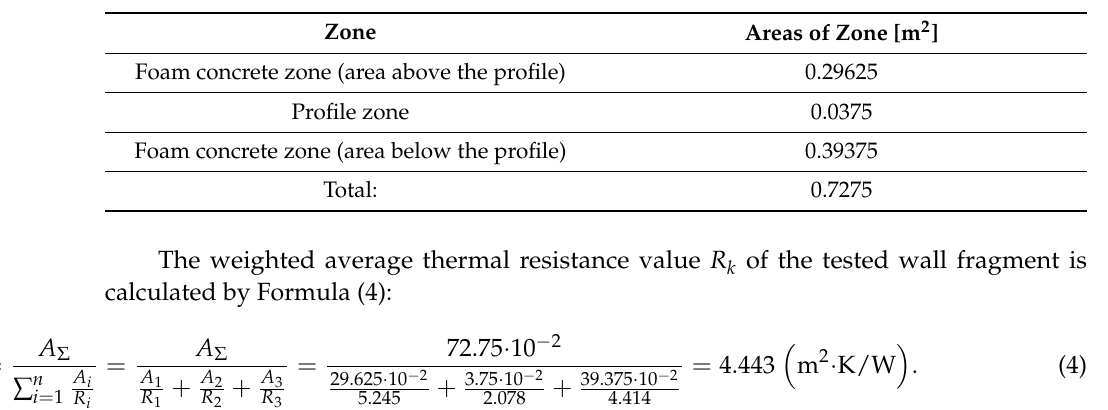
Table 2. Areas of characteristic zones of the wall structure.